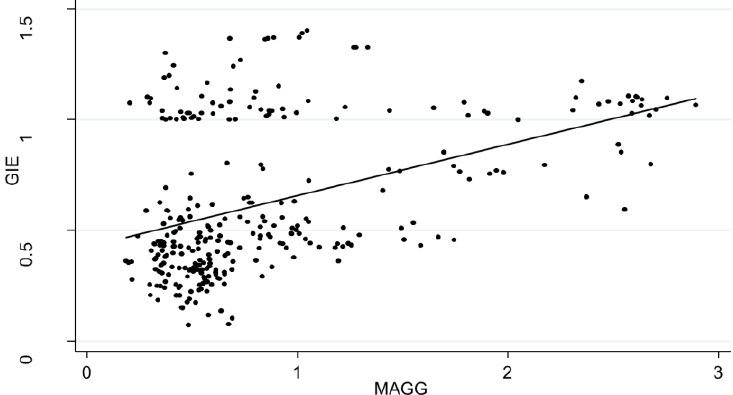
Figure 6. Relationship between MAGG and GIE in China during the years 2010 – 2019.